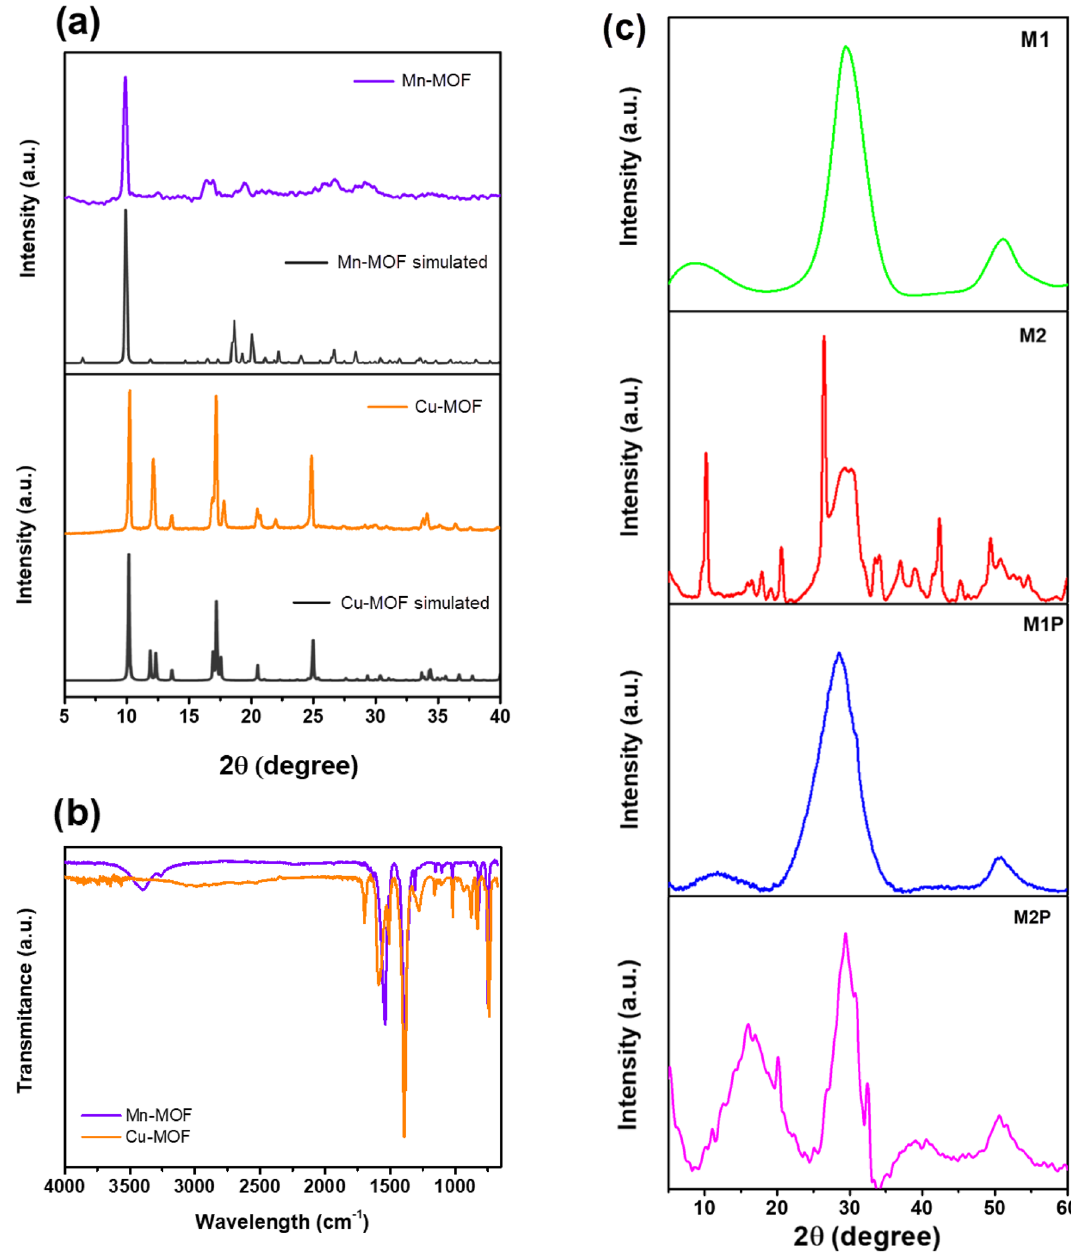
Figure 2. ( a ) XRD and ( b ) IR spectra of Mn-MOF and Cu-MOF; and (c) the XRD spectra of all